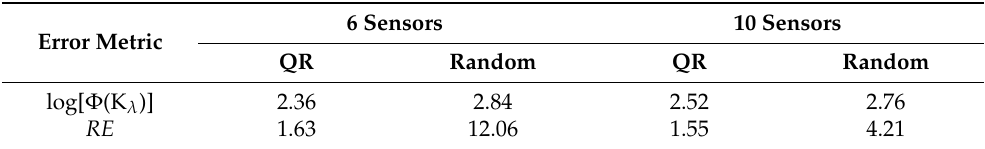
Table 6. Logarithm of condition number of K λ and relative reconstruction errors (%) of random placement and QR pivoting in velocity field (Boundary Condition 2).